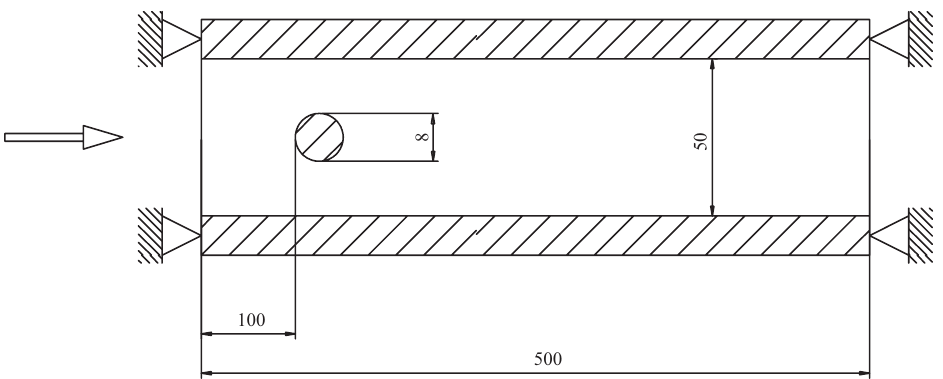
Figure 1. Scheme of the computational domain in the plane of symmetry (dimensions are given in